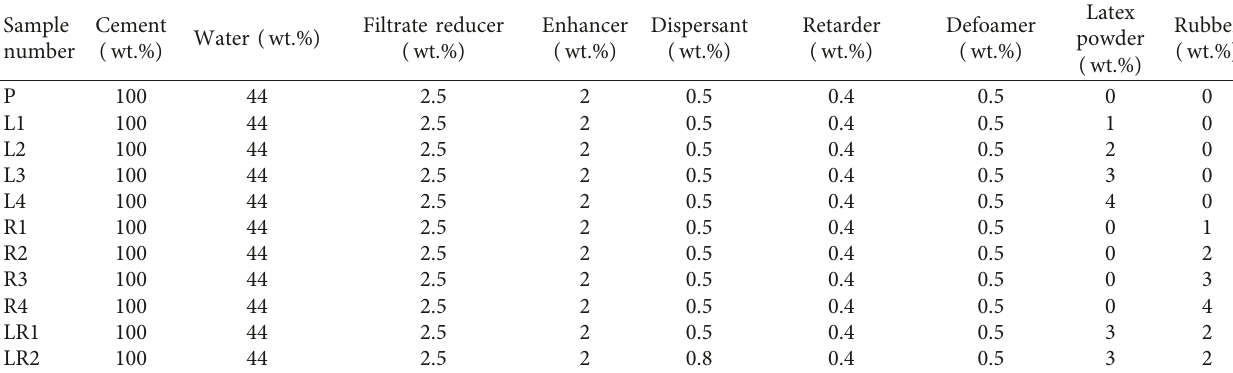
Table 1: Specific compositions of cement slurry.